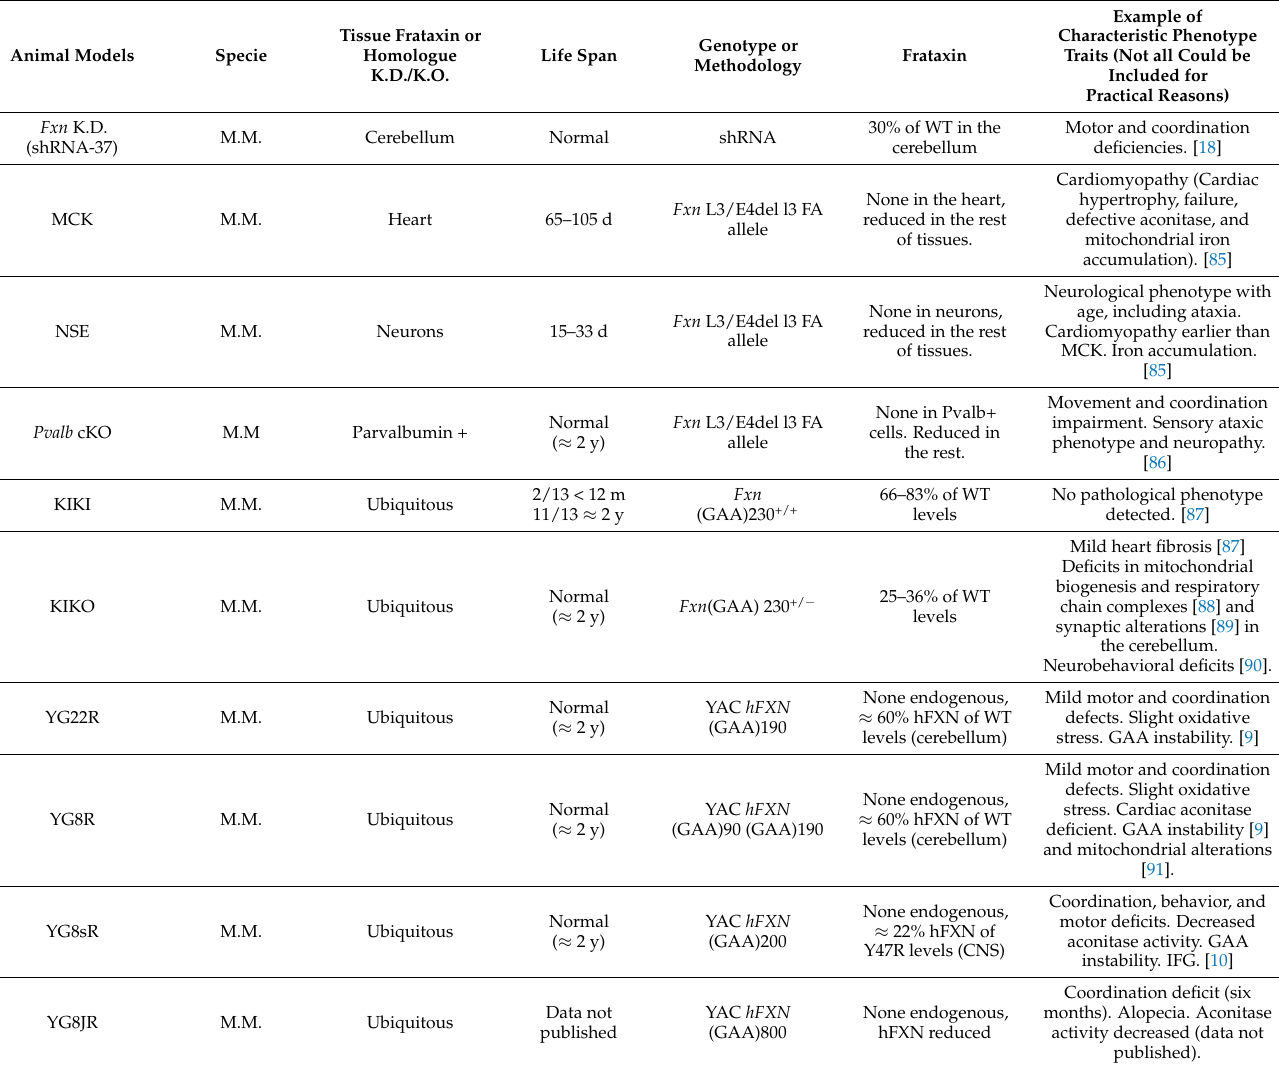
Table 4. Friedreich’s Ataxia main mouse models and their major